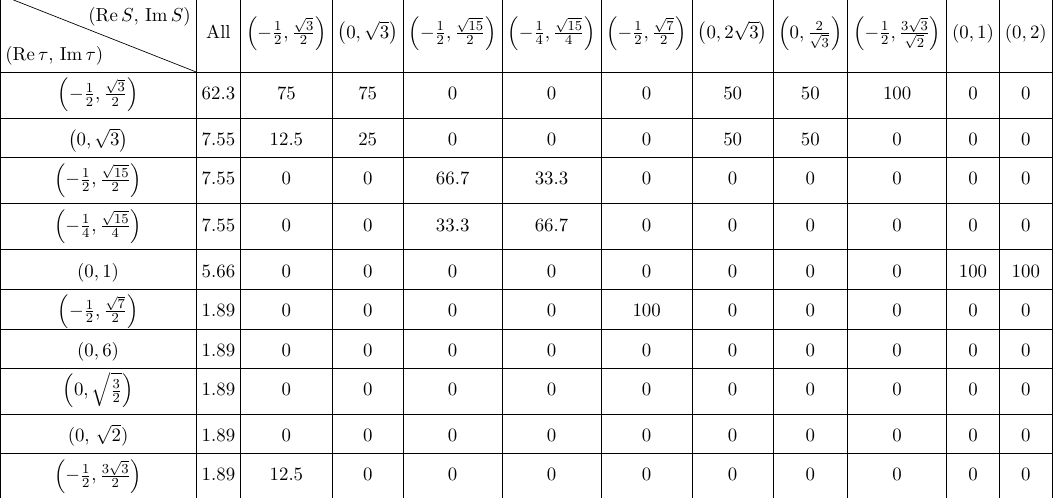
Table 9 . Probabilities of the stable vacua as functions of (Re (cid:28); Im (cid:28) ) and (Re S; Im S ) in